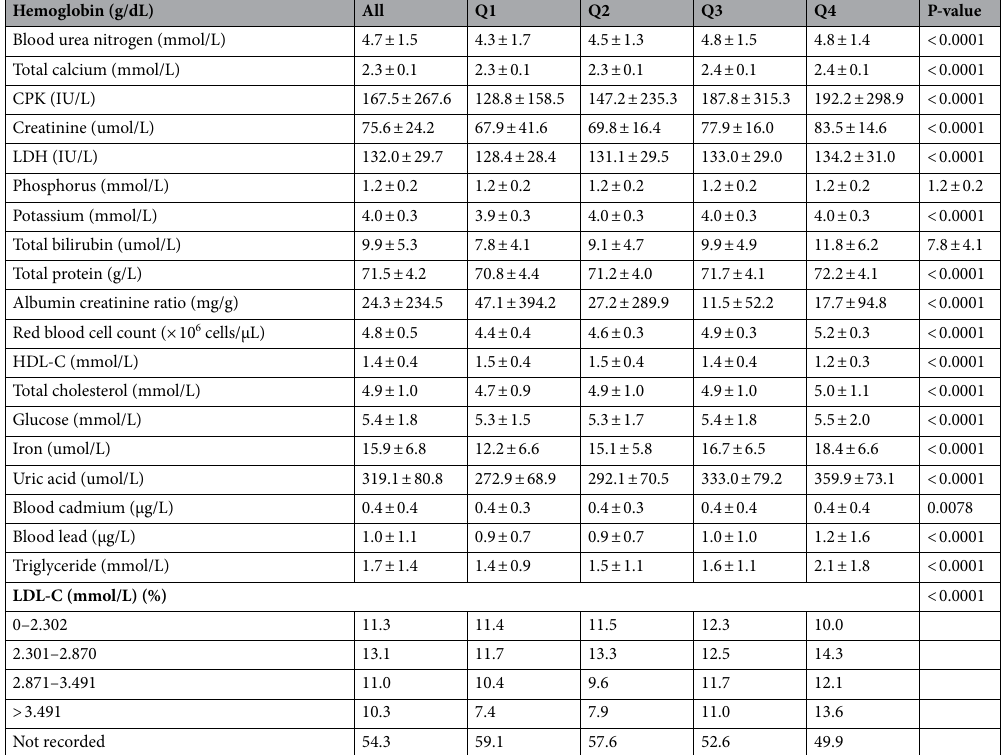
Table 1. Weighted characteristics of the study population. Mean ± SD for continuous variables: P-value was calculated by weighted linear regression model. % for categorical variables: P-value was calculated by weighted chi-square test.